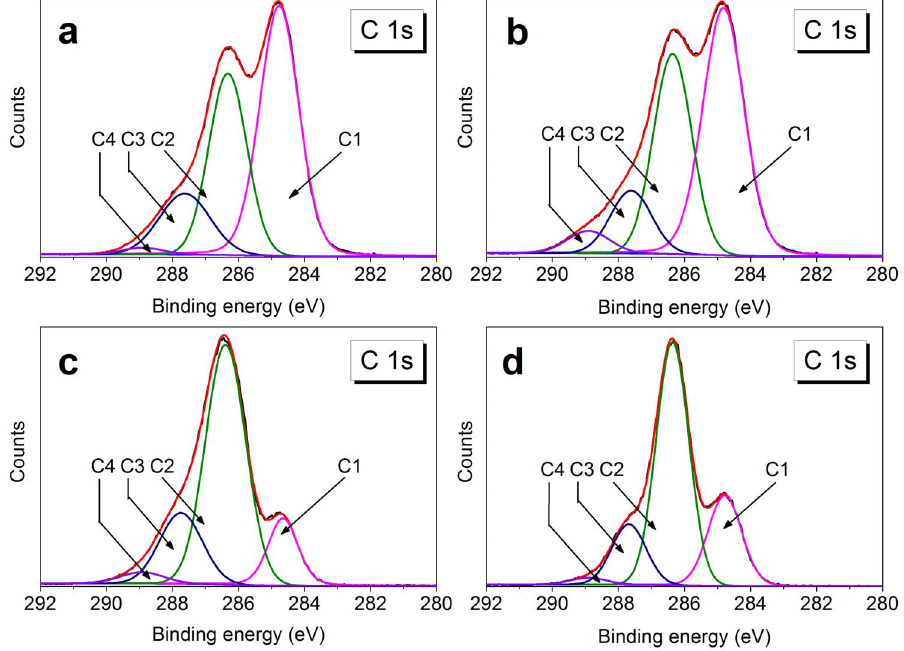
Figure 2. The high-resolution C 1 s deconvoluted XPS spectra of (a) WMS, (b) SNC H2SO4,3 , (c) SNC H2SO4,7 , (d) SNC HCl,7 . doi:10.1371/journal.pone.0086024.g002 PLOS ONE |